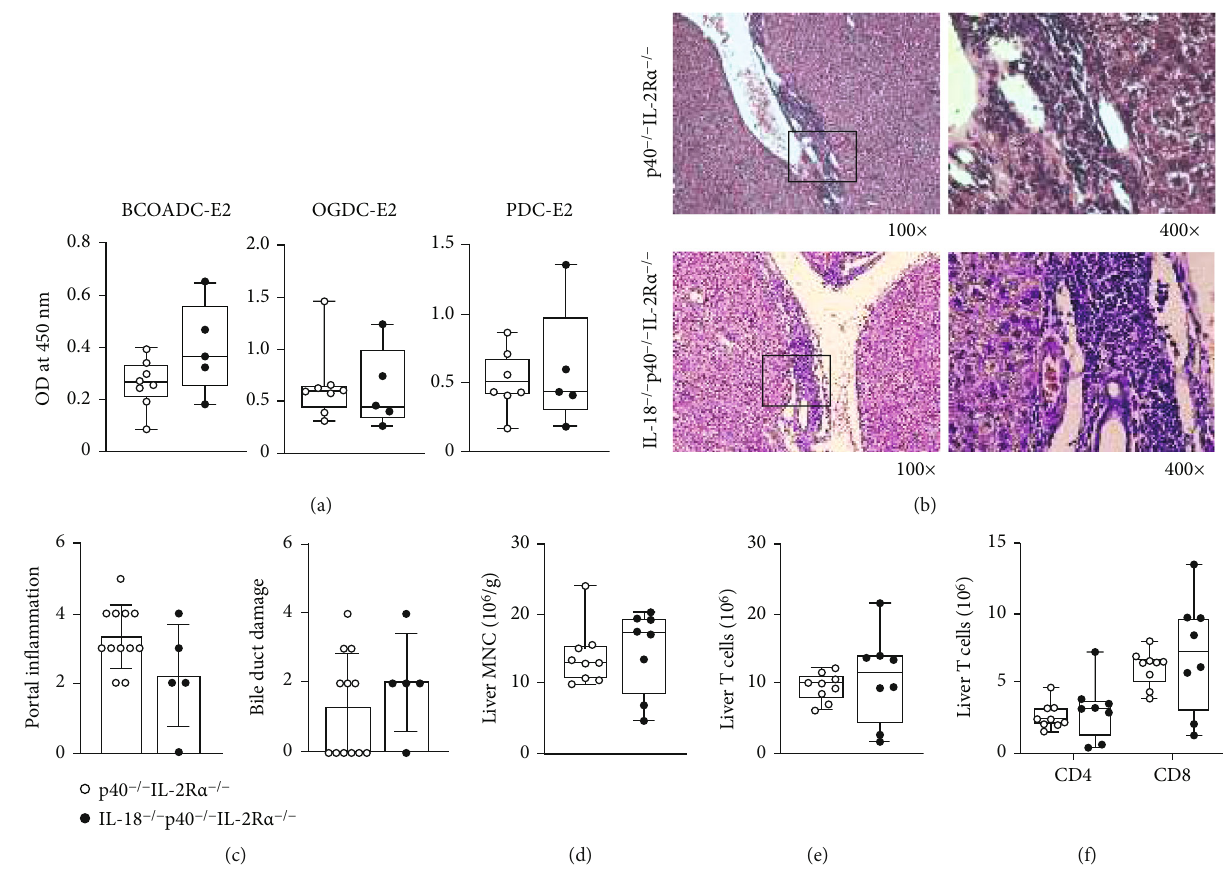
Figure 3: Autoimmune cholangitis in IL-18 -/- p40 -/- IL-2Ra -/- mice. (a) Serum AMA levels in IL-18 -/- p40 -/- IL-2Ra -/- ( n = 5 ) and p40 -/- IL- 2Ra -/- ( n = 8 ) mice. (b) Representative H&E of the liver at 100x and 400x magni fi cation. (c) Liver pathological score of IL-18 -/- p40 -/- IL- 2Ra -/- ( n = 5 ) and p40 -/- IL-2Ra -/- ( n = 12 ) mice. (d) Densities of liver MNCs in IL-18 -/- p40 -/- IL-2Ra -/- ( n = 8 ) and p40 -/- IL-2Ra -/- ( n = 9 ) mice. (e) Numbers of T cells in the liver from IL-18 -/- p40 -/- IL-2Ra -/- ( n = 8 ) and p40 -/- IL-2Ra -/- ( n = 9 ) mice. (f) Numbers of CD4 + and CD8 + T cells in the liver from IL-18 -/- p40 -/- IL-2Ra -/- ( n = 8 ) and p40 -/- IL-2Ra -/- ( n = 9 ) mice. ∗ p < 0 : 05, ∗∗ p < 0 : 01, and ∗∗∗ p < 0 : 001